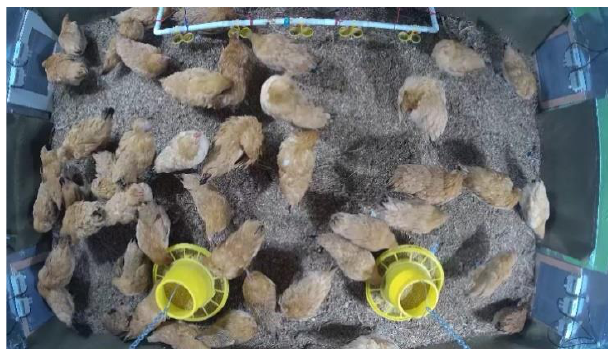
Figure 6. Field map of winter broiler breeding.